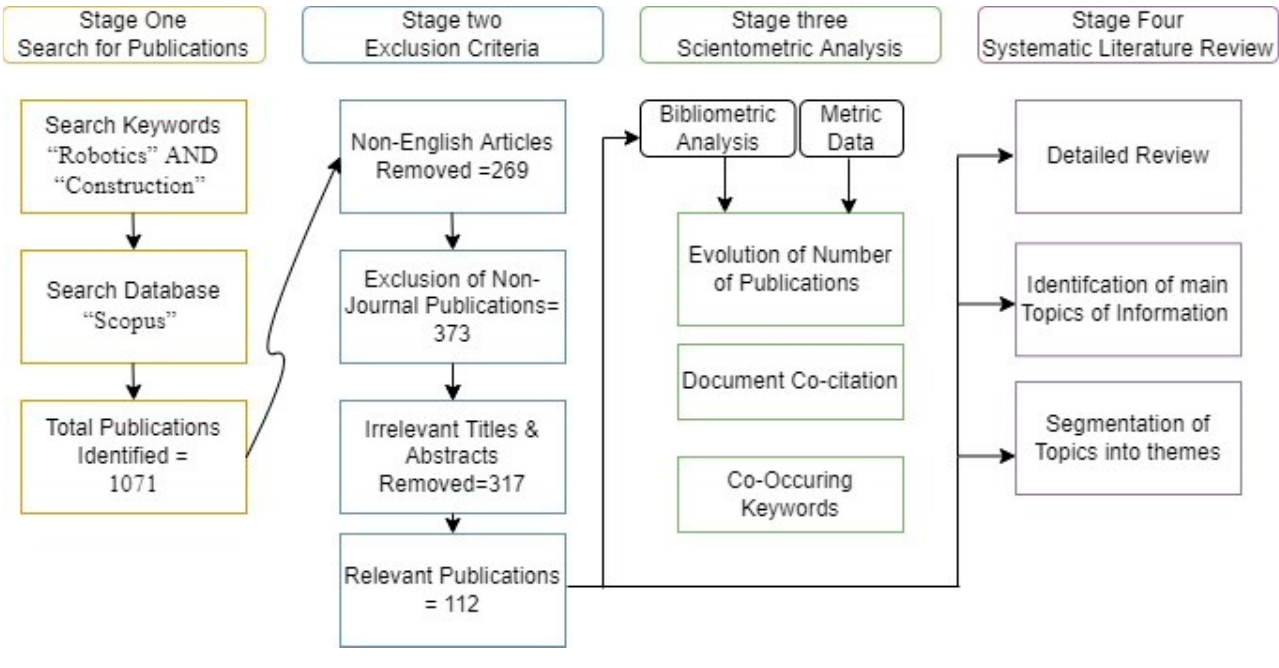
Figure 1. Research method for the study.